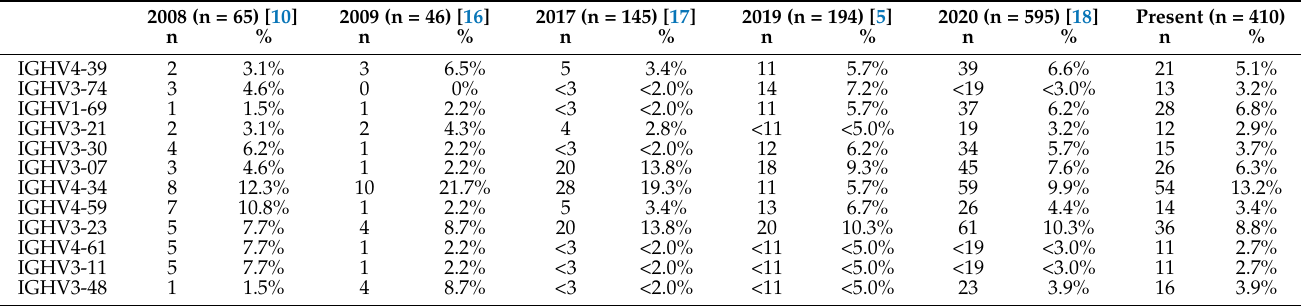
Table 2. IGHV subfamily usage in recent Chinese CLL/SLL studies.